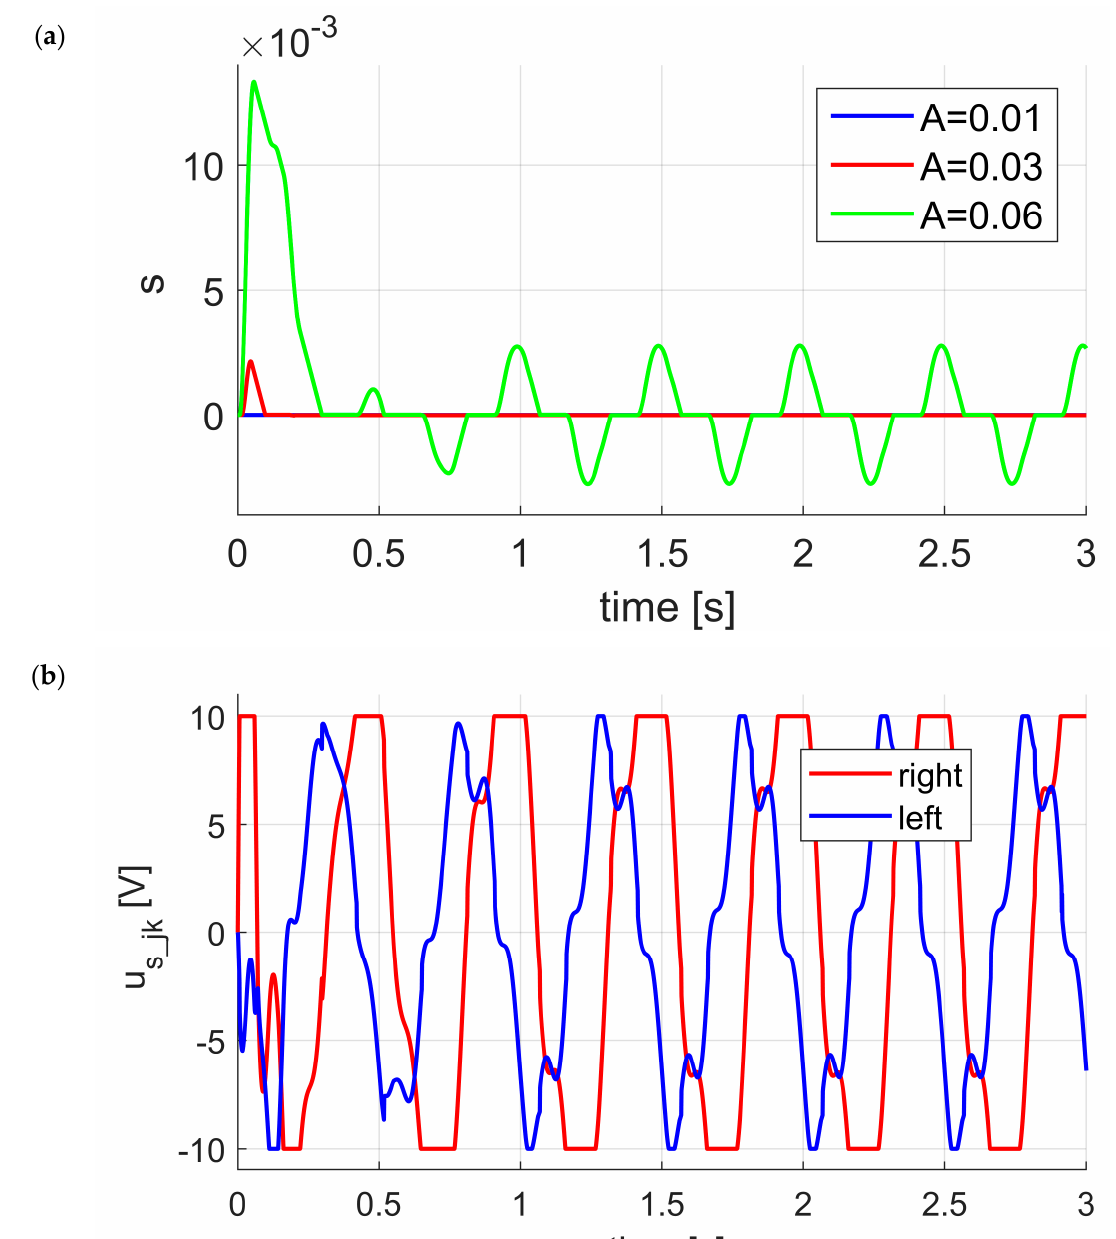
Figure 9. Time courses of the function describing sliding surface for three amplitudes of road disturbances ( a ) and the left and right strut control signals for A w _ jR = A w _ jL = 0.06 m, f w _ jR = f w _ jL = 2 Hz ( b ).